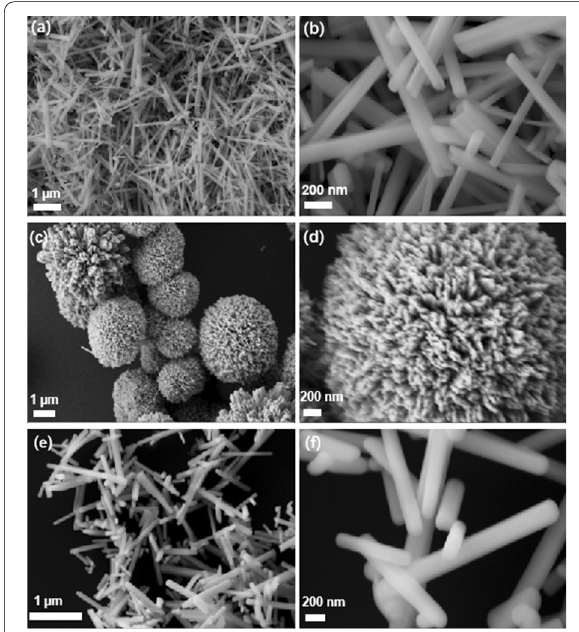
Fig. 2 SEM images of the a , b Bi 2 S 3 nanotubes; c , d Bi 2 S 3 nanoflowers; and e , f